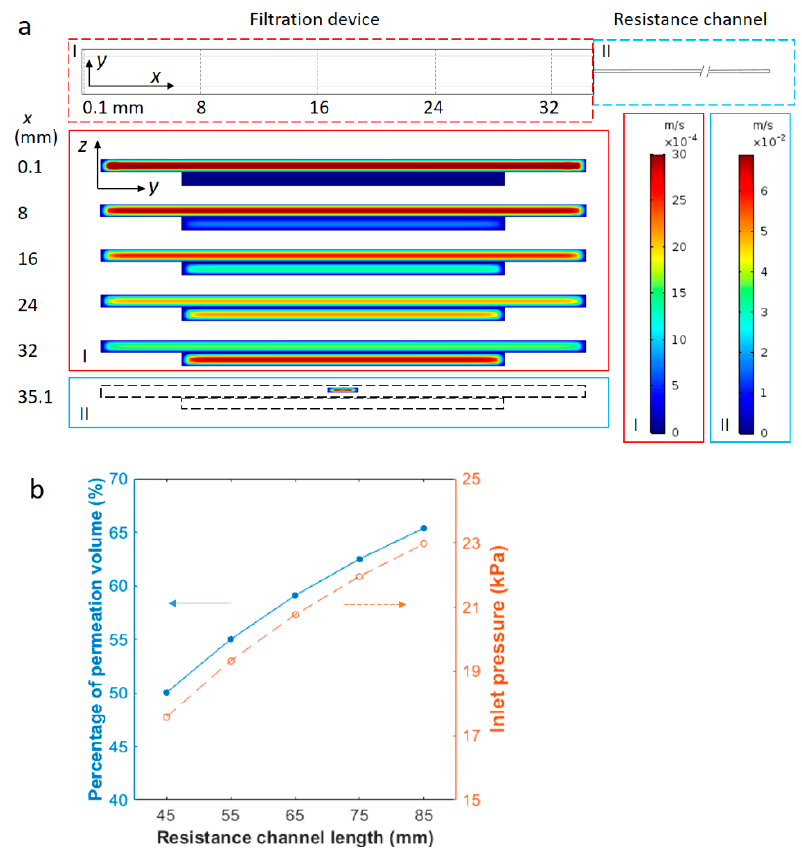
Figure 3. Magnitude profile of + x velocity and permeation percentage in the device from COMSOL simulation. ( a ) The top view of the simulated device and profiles of the axial velocity in y - z cross sections of the channel at different distances from the inlet. The simulated geometry contains a filtration device (region I) of two channels separated by a porous membrane and a 65-mm-long resistance channel (region II). The top channel of the filtration device is connected to the resistance channel, while the bottom channel is open to air at the outlet. The velocity profiles correspond to positions of different cross sections along the + x direction. These positions are labeled on the left of the velocity profiles in values (mm) and also as dashed lines in the x - y view of the simulated device (top). Axial flow is along the + x direction and the average inlet velocity is 2.4 mm/s. The left color legend of velocity magnitudes corresponds to the filtration device (region I) and right color legend corresponds to the resistance channel (region II). The magnitude of the axial velocity is observed to decrease in the top channel, but increase gradually in the bottom channel from the inlet to the outlet. ( b ) Fluid fraction permeating through the membrane and inlet pressure as a function of the resistance channel length. The blue solid circles correspond to the left y -axis and empty orange circles correspond to the right y -axis. The lines are to guide the eyes. The cross-sectional area of the resistance channel is constant. The average flow velocity at the inlet is 2.4 mm/s in all cases.